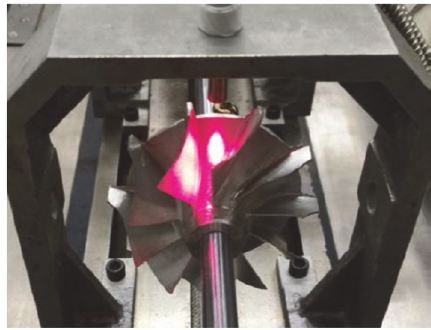
Figure 7: Simulated rotor and optical fiber displacement sensor.